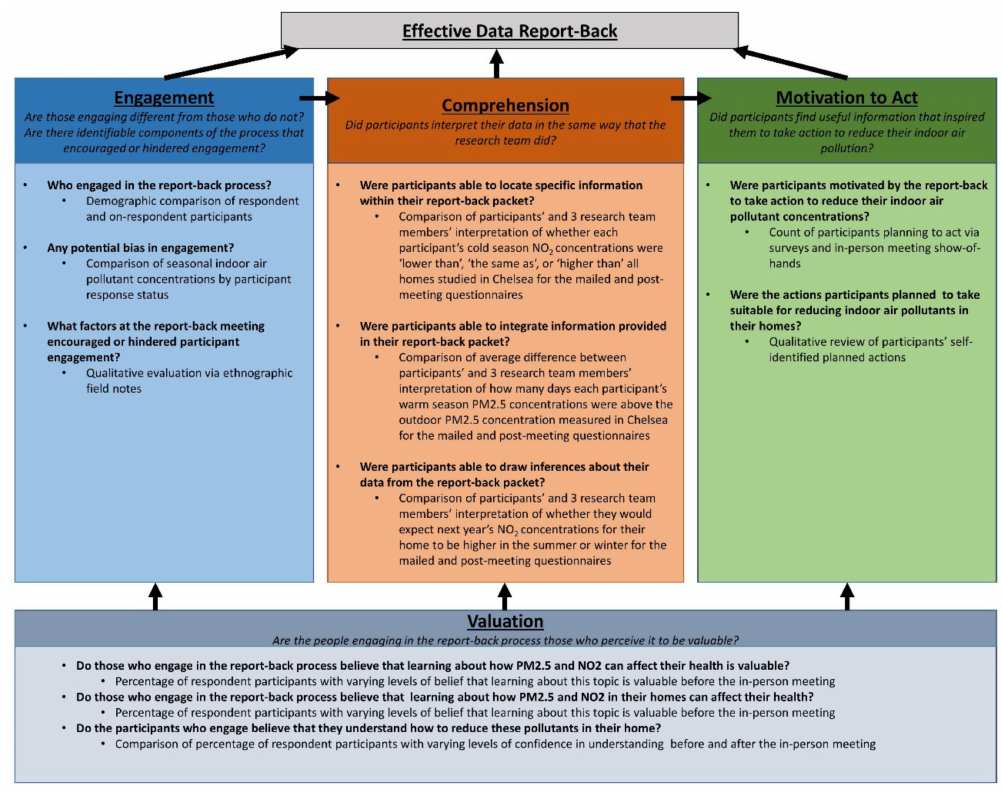
Figure 1. Logic model of e ff ective report-back